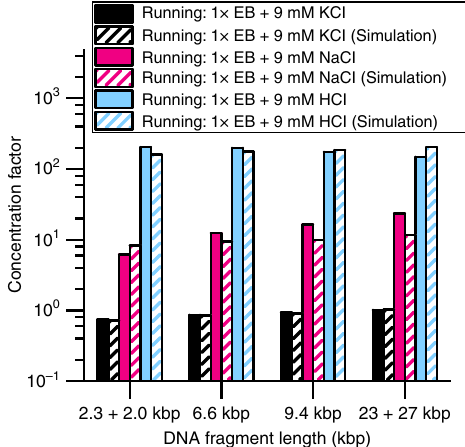
Fig. 5 Effect of running buffer cation species on MRT concentration factor. The same buffering species are used in both the reservoir and running buffers: 1× EB (10 mM EACA and 40 mM Bis-Tris). Running buffer contains an additional 9 mM of the indicated species (KCl, NaCl, HCl). The concentration factor after 2 min of counter fl ow at 200 psi is plotted from experimental (solid) and simulated (striped) results. When KCl is added to the running buffer (black), the DNA does not concentrate above the starting concentration. When NaCl is added to the running buffer (pink), a 10-fold concentration effect is observed. The running buffer containing HCl (blue) results in the highest concentration factor — over